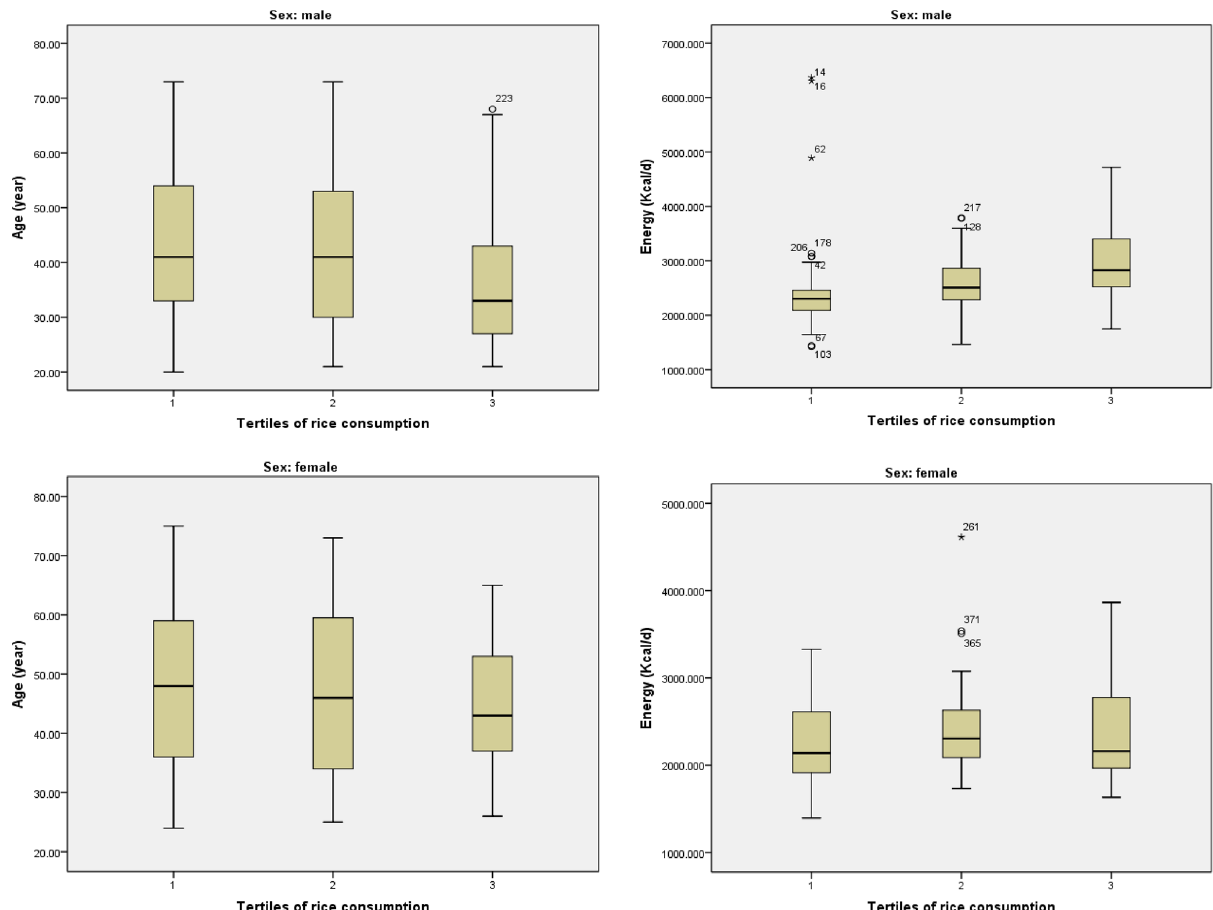
Figure 1. Distribution of age and energy intake of men and women across tertiles of rice